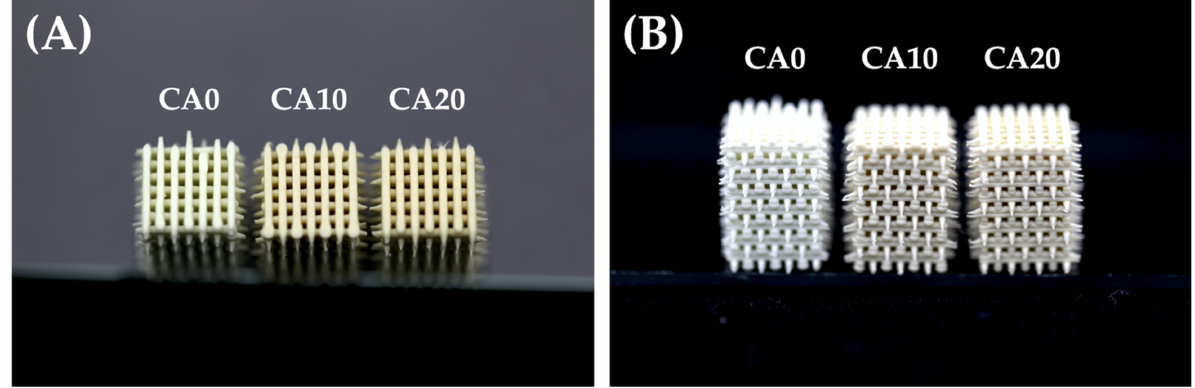
Figure 1. ( A ) The top view and ( B ) side view photographs of various CA-coated MTA